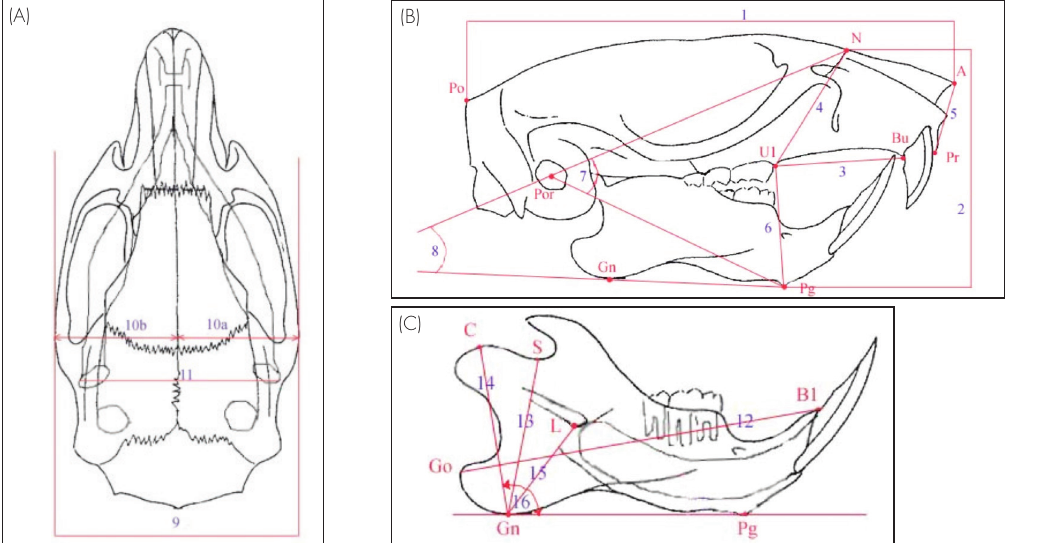
Figure 2. Cephalometric measurements taken from three radiographic views from each rat: (A) Submento-vertex view. (B) Lateral cephalometric view. (C) Hemi-mandibular view. Measurements adapted from previous work. 37,12